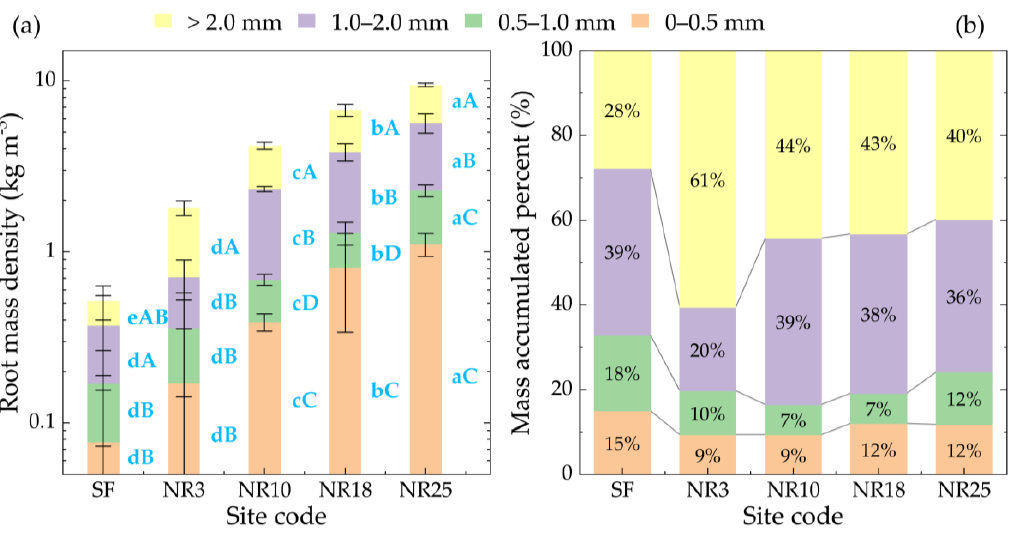
Figure 4. Changes in root mass density ( a ) and its proportion ( b ) of different root diameters with revegetation age. Note: Bar means the 95% confidence interval (95% CI). SF refers to the slope farmland. NR3, NR10, NR18, NR25 represents the 3, 10, 18, and 25 years of natural restoration time, respectively. Different capital letters for the same restoration age indicate a significant difference among different root diameters ( p < 0.05), and different lowercase letters for the same root diameter level indicate a significant difference among different revegetation ages ( p < 0.05). ( a ) Root mass density; ( b ) Mass accumulated percent.